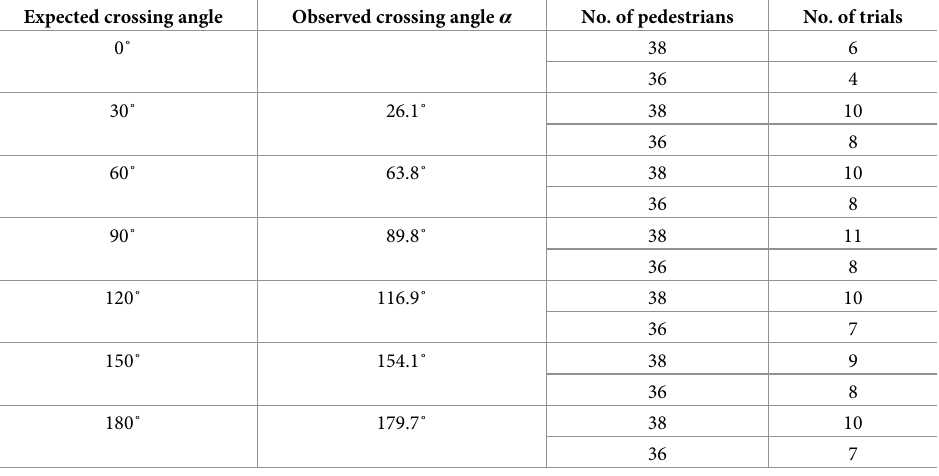
Table indicates number of pedestrians and number of trials categorized according to the value of the crossing angle. The observed values of the crossing angle which are mentioned here are basically the median values over all the